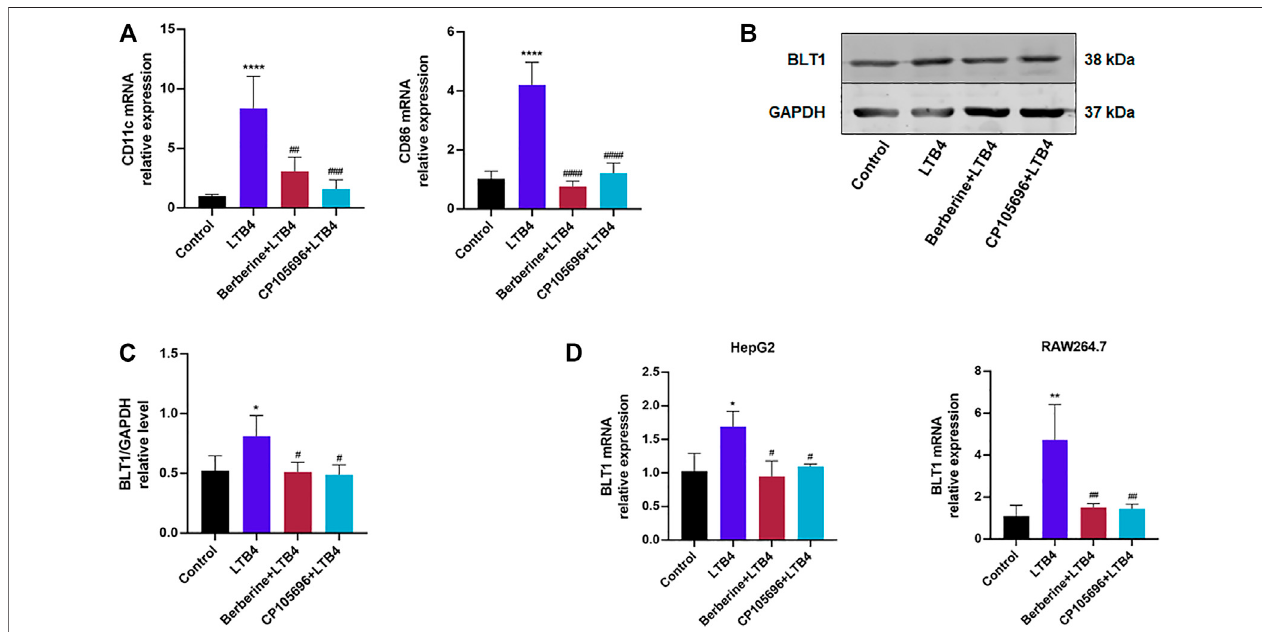
FIGURE 5 | BBR may inhibit LTB4-induced polarization of RAW264.7 cells to M1 macrophages and regulate BLT1 of HepG2 and RAW264.7 cells. (A) Gene expressions of CD11c and CD86 in RAW264.7 were determined by RT-PCR ( n (cid:2) 4). (B) Western blots exhibited the protein level of BLT1 in HepG2 cells. (C) Densitometric analysis of BLT1 in the total protein of HepG2 cells was calculated ( n (cid:2) 4). (D) BLT1 gene expression in HepG2 and RAW264.7 cells determined by RT- PCR ( n (cid:2) 3). Error bars represent mean ± SD. Berberine, 10 μ M; CP105696, 10 μ M; LTB4, Leukotriene B4. * p < 0.05 vs. Control; # p < 0.05 vs. LTB4. ** p < 0.01; *** p < 0.001, **** p < 0.0001; ## p < 0.01; ### p < 0.001; ### p <